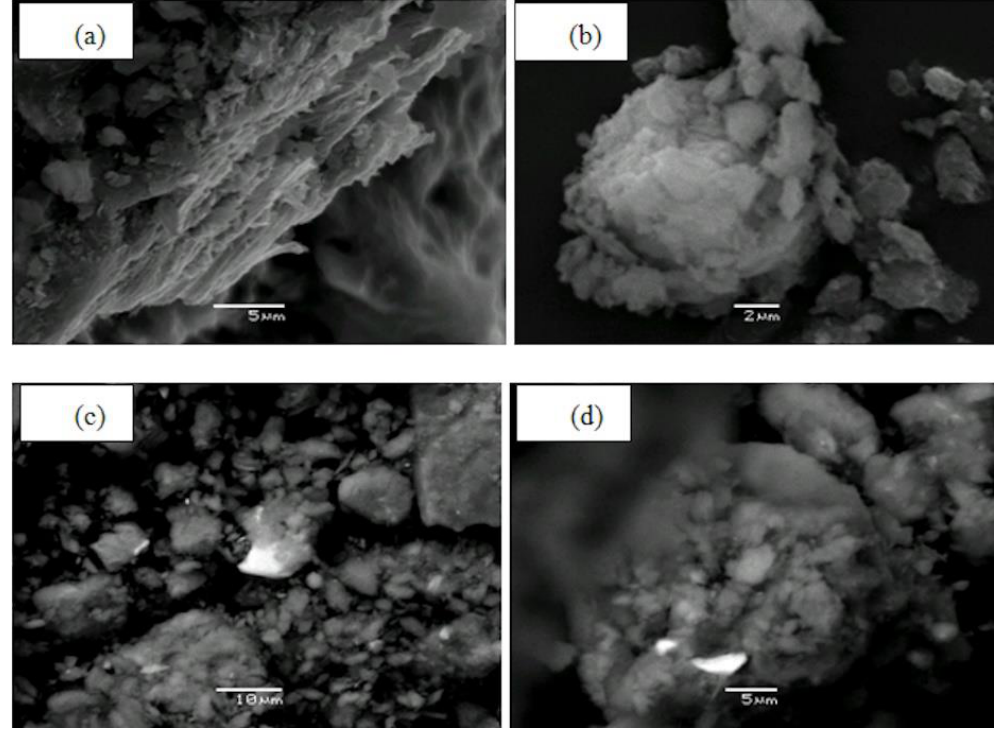
Figure 2. SEM microphotographs showing the porous morphology of attapulgite clay particles: ( a , b ) before interaction with Pb aqueous solutions and ( c , d ) after interaction with Pb aqueous solutions.